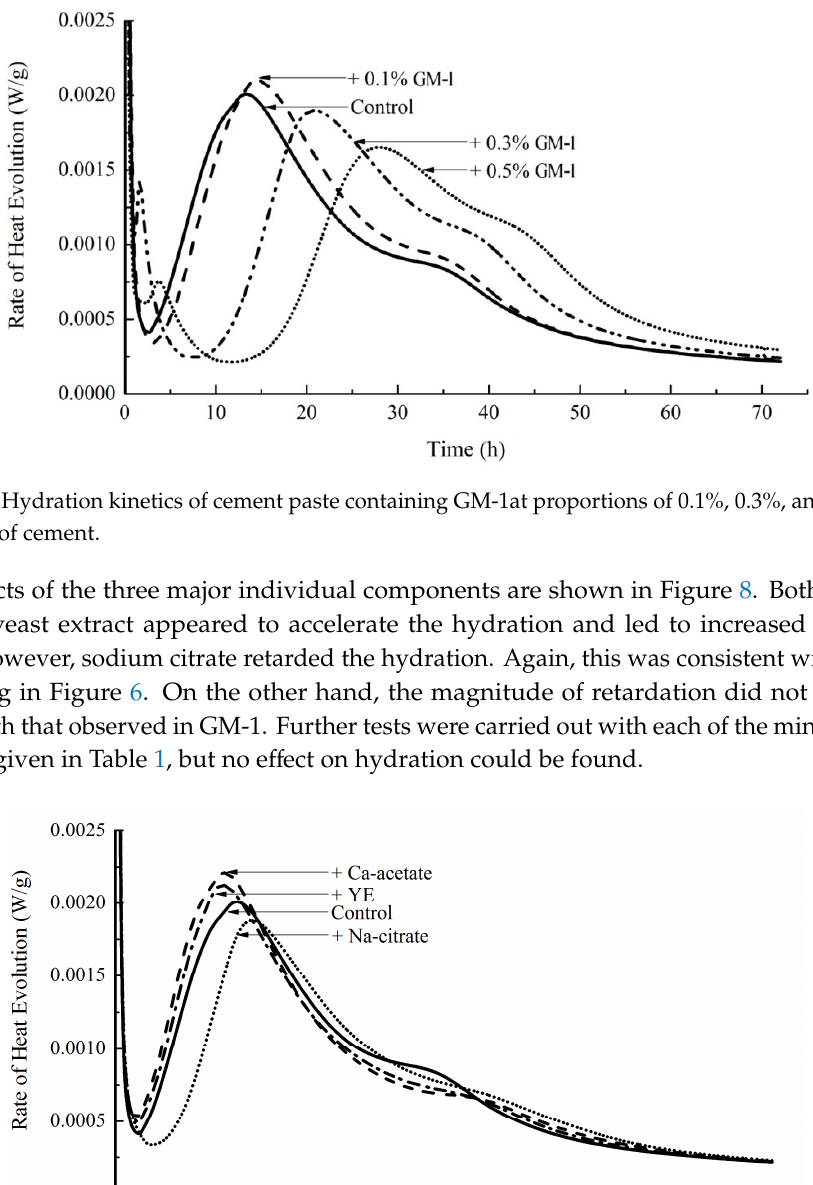
Table 5. Composition of GM-2 (% by mass). Self-Healing Component